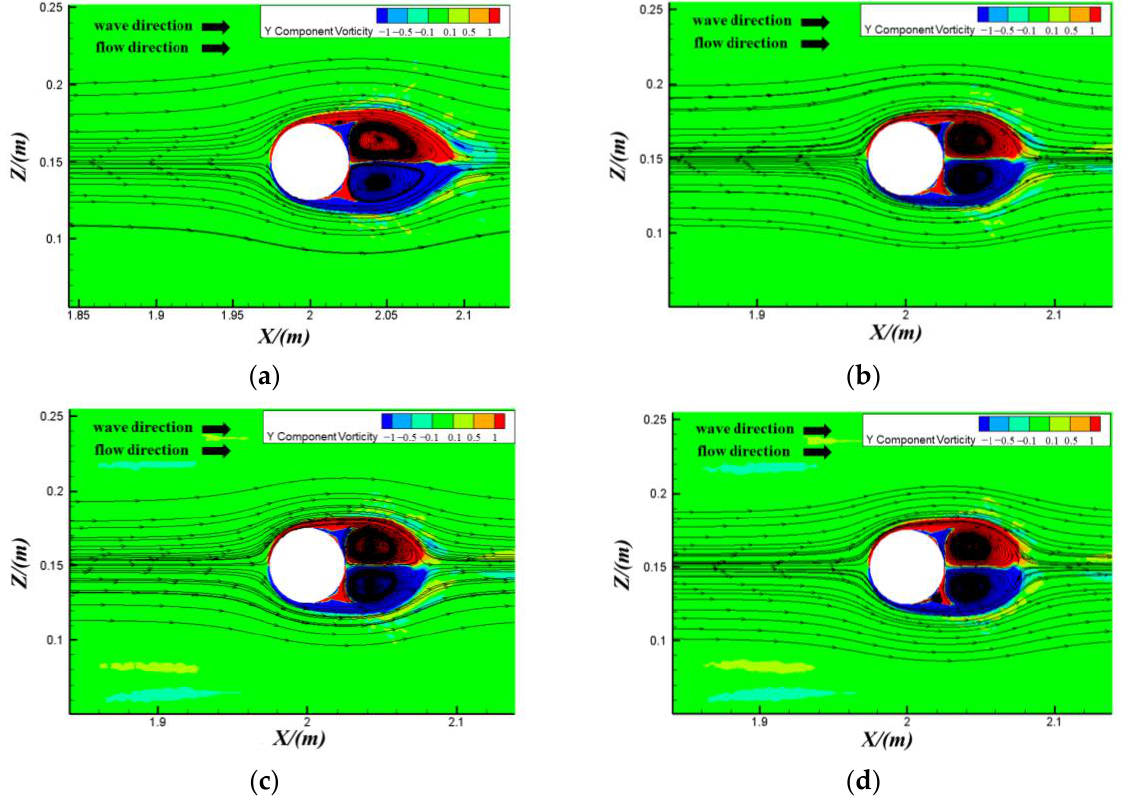
Figure 11. Plots of vorticity around the cylinder at P 0.26 : ( a ) N 1 , ( b ) N 2 , ( c ) N 3 , ( d ) N 4 , when C Fn = C Fn-max .